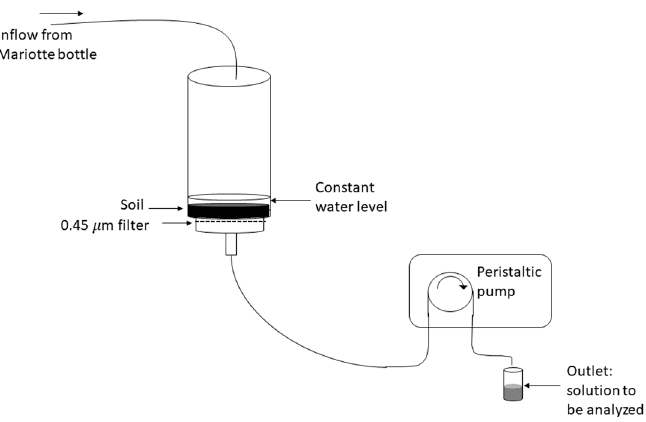
Figure 1. Schematic of flow-through soil phosphorus desorption apparatus.